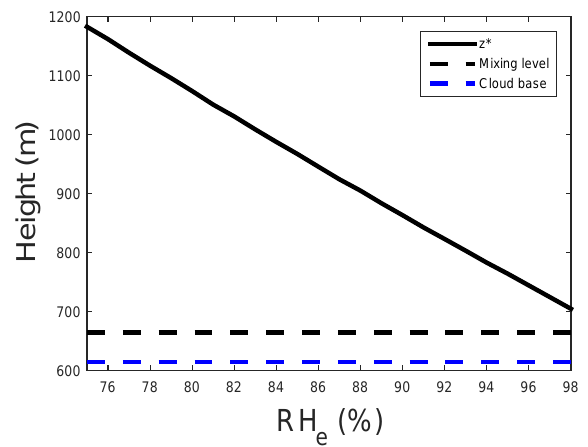
Figure 6. Critical height z ∗ vs. environmental relative humidity RH e at the mixing level. The height of cloud base (blue dashed line) and the mixing level (black dashed line) are shown for